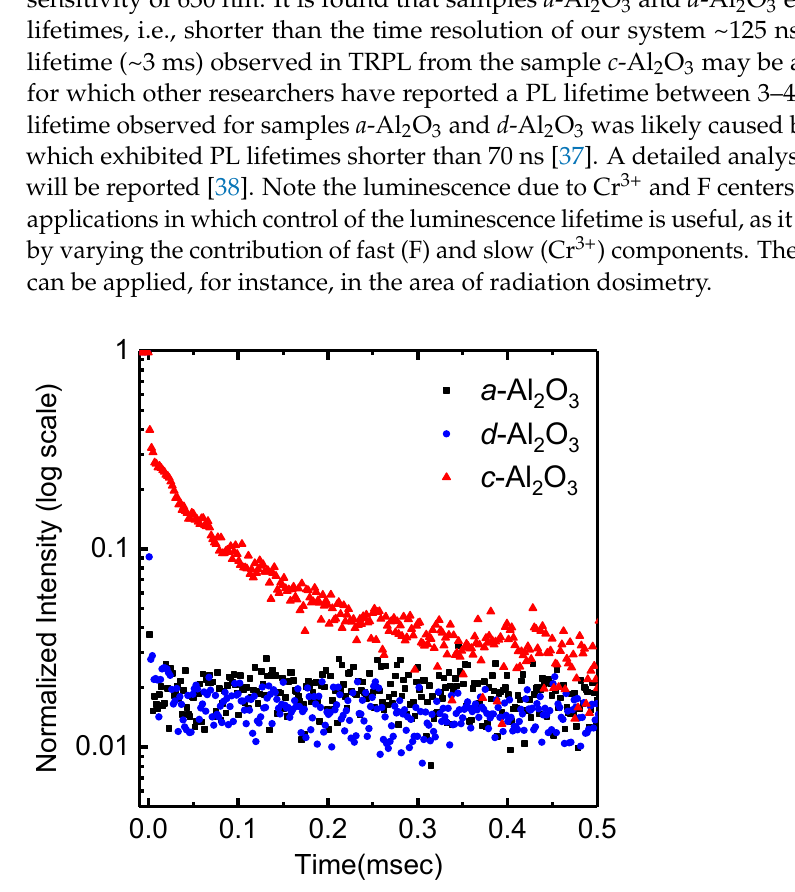
Figure 4. Photoluminescence spectra of α -Al 2 O 3 (amorphous, solid black line), d -Al 2 O 3 (disordered, solid blue line), and c -Al 2 O 3 (crystalline, solid red line) samples implanted with Si ions and annealed at 1200 °C (with a vertical offset and magnified where indicated for clarity). The samples before implantation and annealing are labelled “blank”.